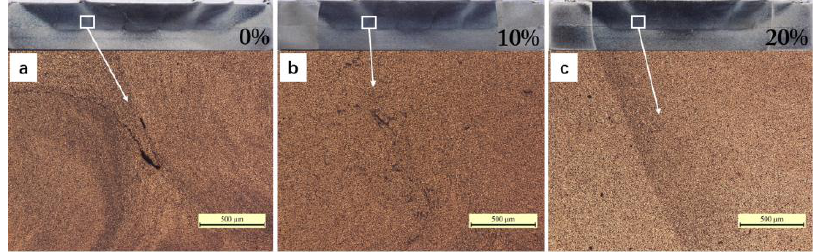
Figure 8. Local magnifications of overlap regions at different overlapping rates in multi-track samples: ( a ) 0%, ( b ) 10%, and ( c ) 20%